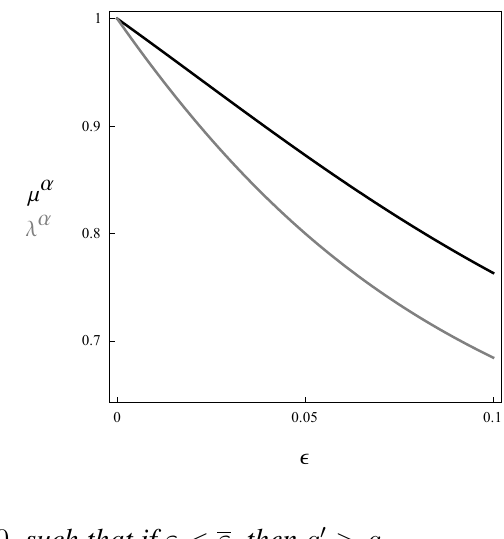
Figure 2. Steady state fractions of individuals of reproductive type α in the population without suicide ( λ α ) and with ( µ α ), as a function of (cid:15) and letting α = 1 . 5 and β = 1 . 2 .